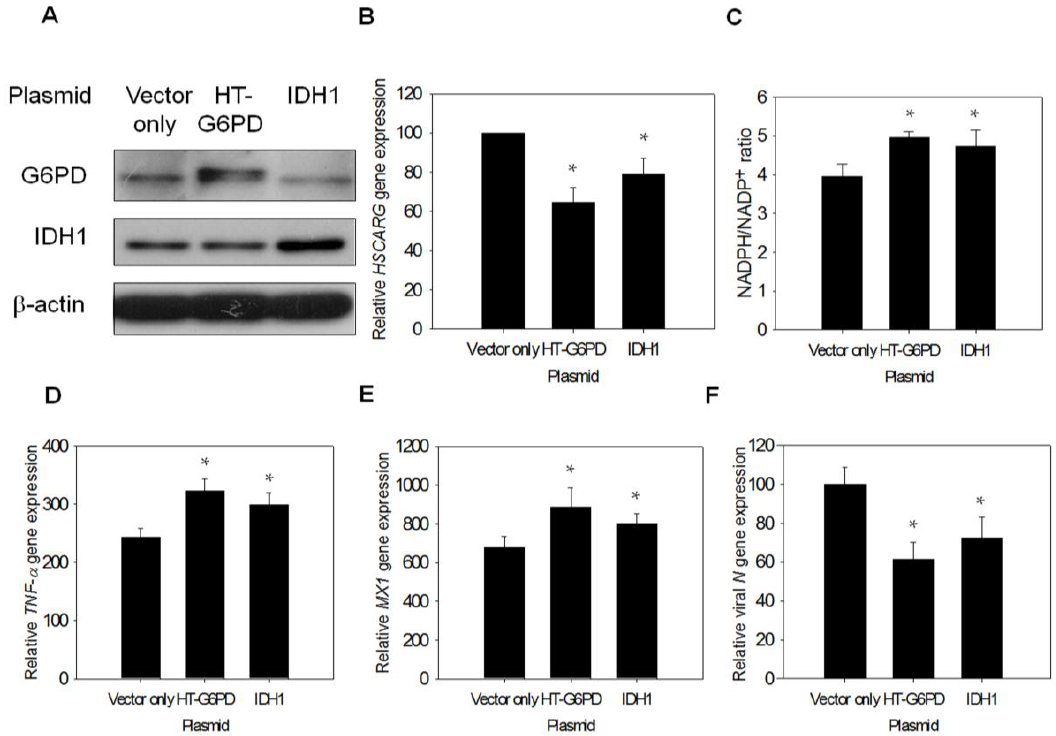
Figure 7. Expression of G6PD or IDH1 gene augments antiviral gene expression in HCoV-229E-infected A549-Gi cells. ( A , B ) A549-Gi cells were transfected with expression construct encoding His-tagged G6PD or IDH1. Forty-eight hours later, RNA and cell lysate were harvested for analysis. Ectopic protein expression of HT-G6PD or IDH1 was measured by western blot. The level of HSCARG gene expression was determined by quantitative-PCR. The level of HSCARG gene expression was normalized to that of vector only-transfected cells; ( C ) NADPH and NADP + content were determined by UPLC, and NADPH/NADP + ratio was calculated. * p < 0.05 as compared to vector only control; ( D – F ) The A549 cells were transfected with expression construct encoding His-tagged G6PD or IDH1, and cells were infected with HCoV-229E at 0.1 MOI 48 h later; Total RNA was harvested for determination of expression level of TNF- α (at 2 h post-infection) ( D ); MX1 (at 8 h post-infection) ( E ) and viral gene (at 8 h post-infection) ( F ) by quantitative-PCR. Data are expressed relative to that of cells transfected with control vector. Values present the average ± SD of three experiments. * p < 0.05 as compared to vector only-transfected cells.